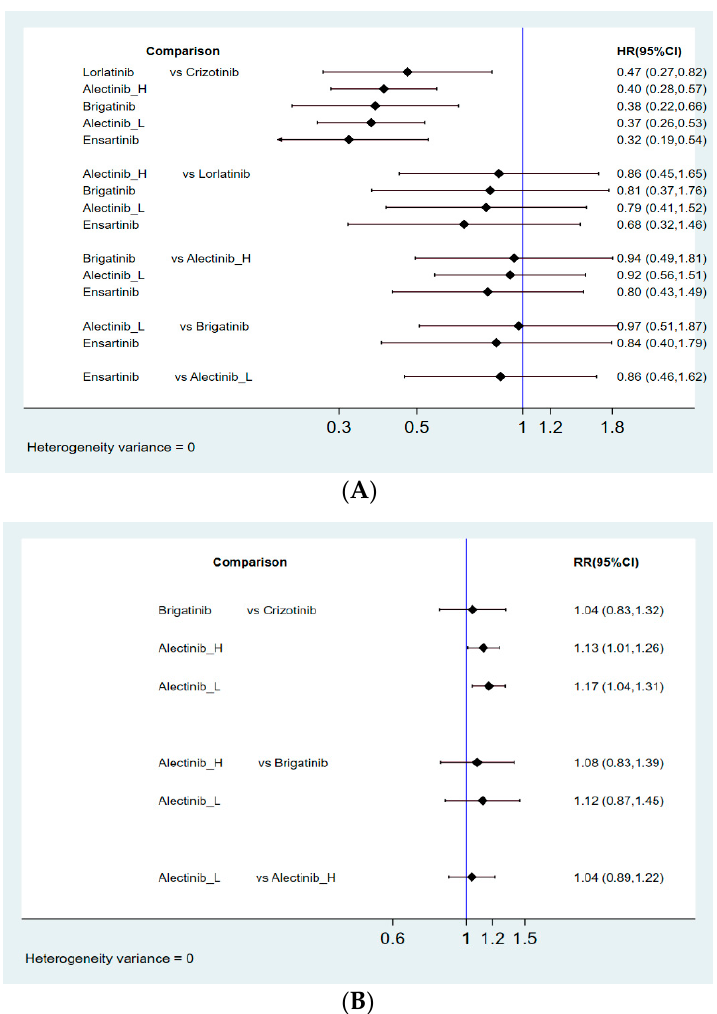
Figure 2. Network constructions for comparisons in PFS and ORR: ( A ) network constructions for PFS, ( B ) network constructions for ORR.